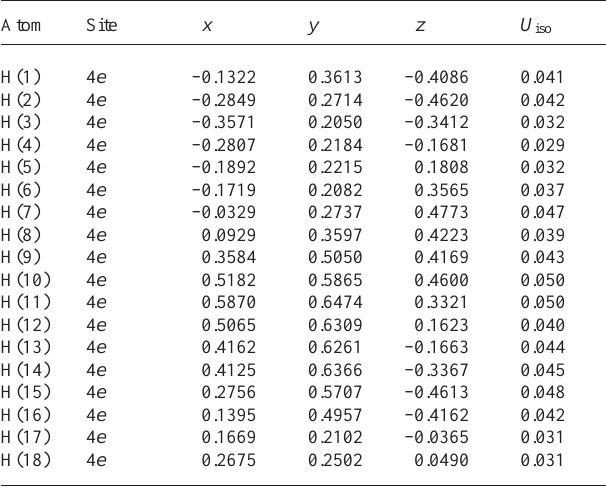
Table 2. Atomic coordinates and displacement parameters (in Å 2 )